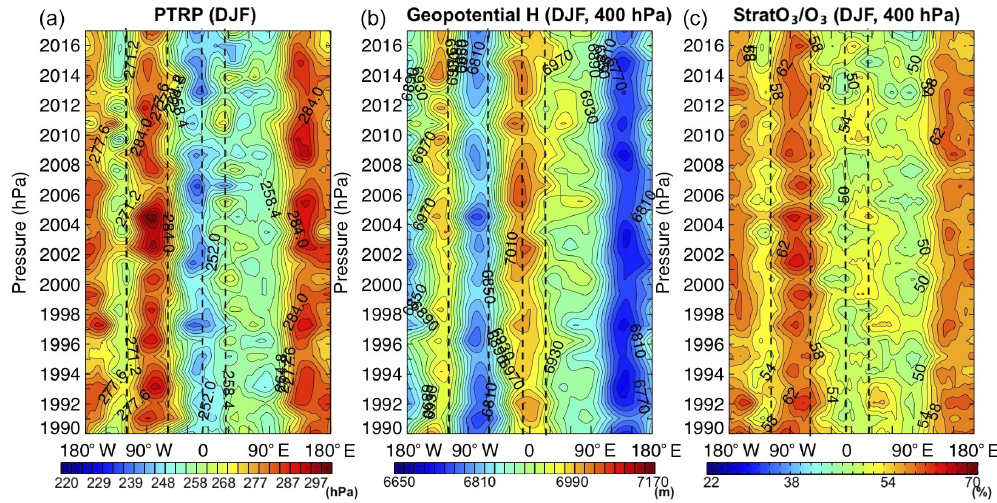
Figure 7. Latitudinal average between 30 and 80 ◦ N of (a) the tropopause pressure, (b) the geopotential height at 400hPa and (c) the StratO 3 / O 3 ratio at 400hPa along each longitude from 180 ◦ W to 180 ◦ E from 1990 to 2016 in winter (DJF). Dashed lines indicate the longitudinal range for the North American region (120–60 ◦ W) and the European region (10 ◦ W–26 ◦ E).